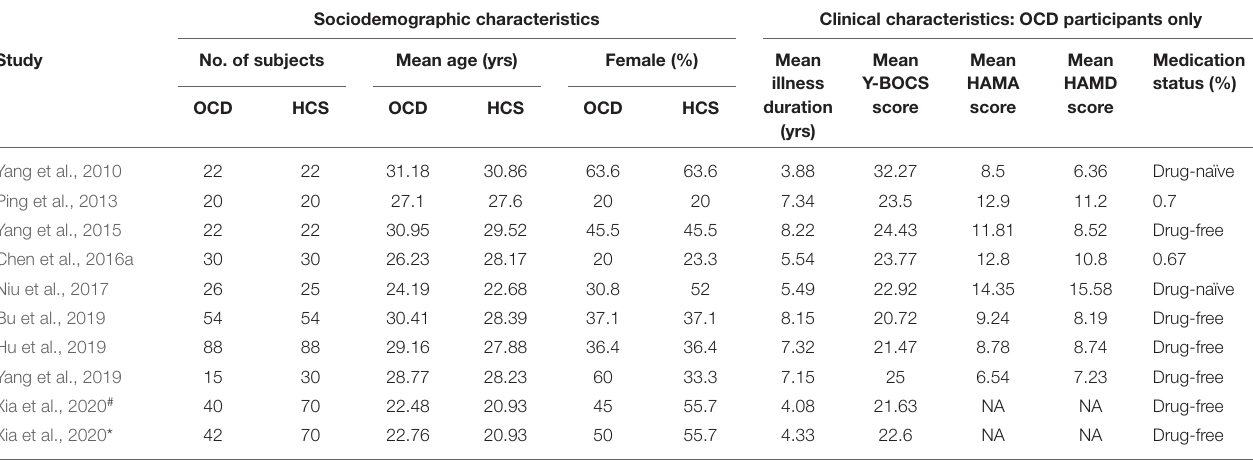
TABLE 1 | Demographic and clinical characteristics of ReHo studies on OCD in the current meta-analysis. Sociodemographic characteristics